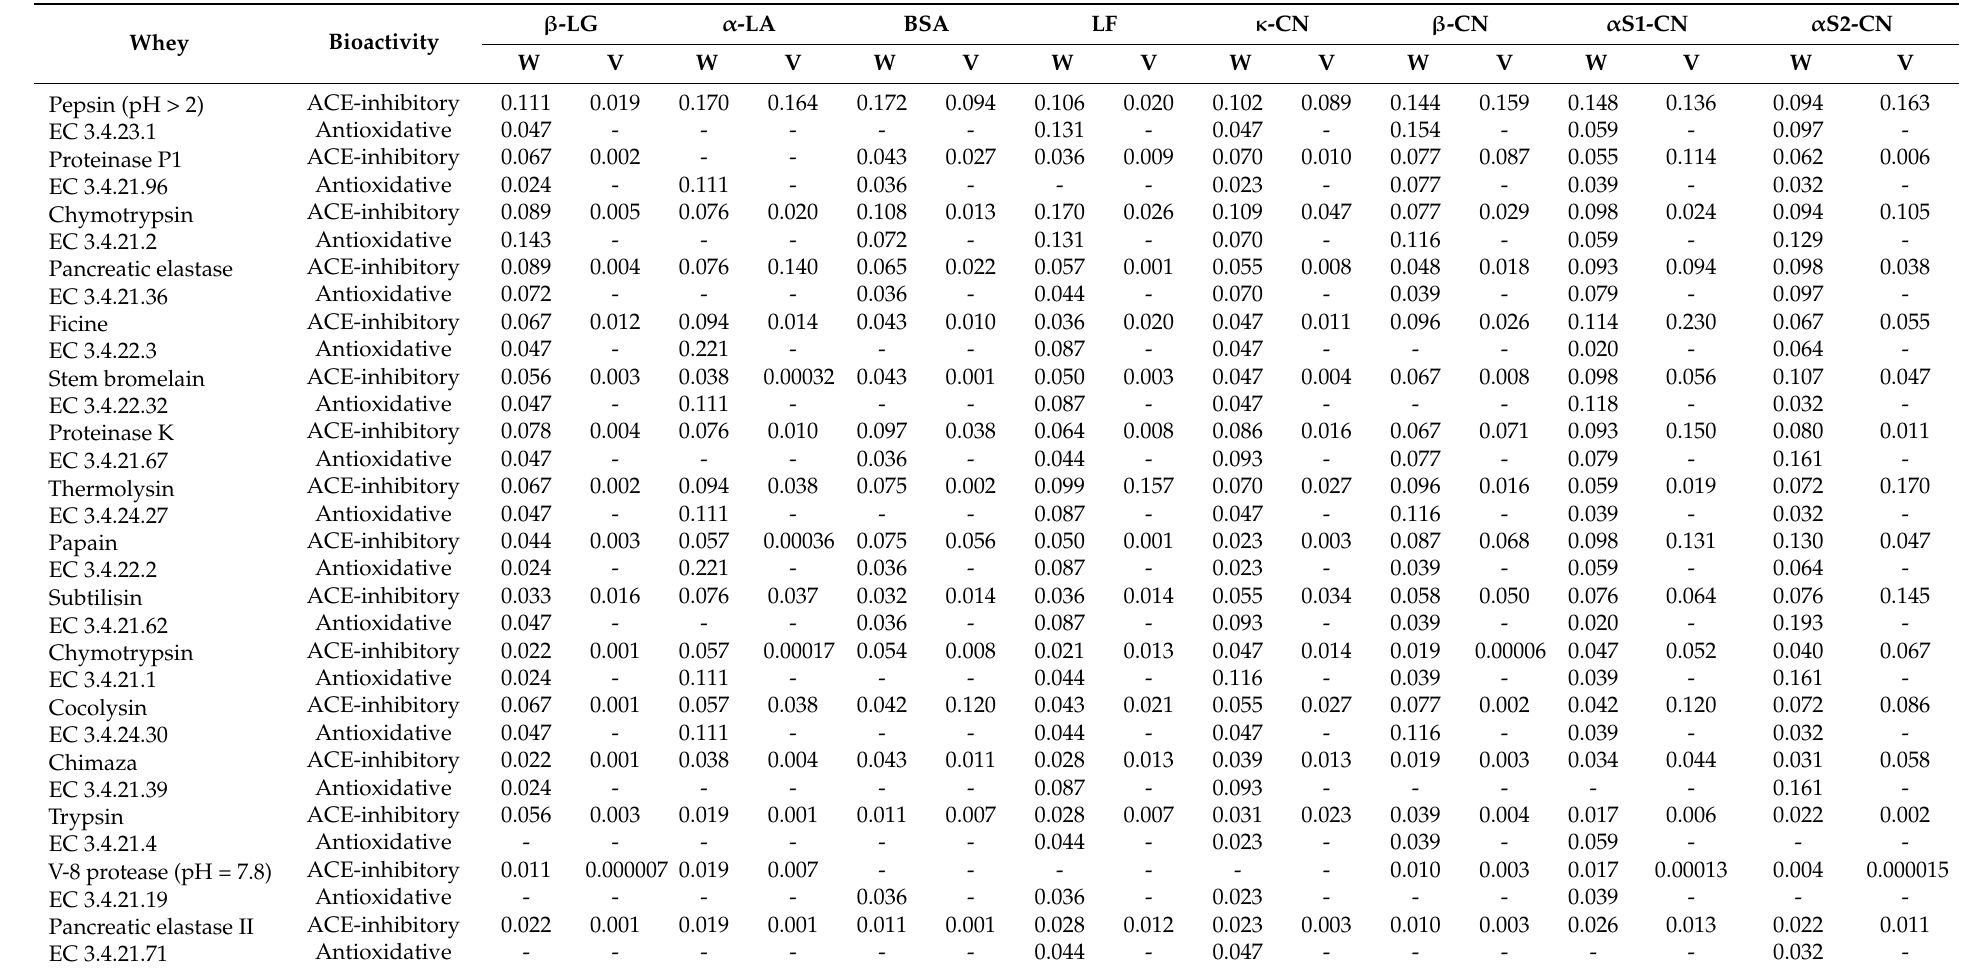
Table 3. Evaluation of the relative frequency (W) and activity of peptides (V) released from milk whey proteins when modeling hydrolysis by different